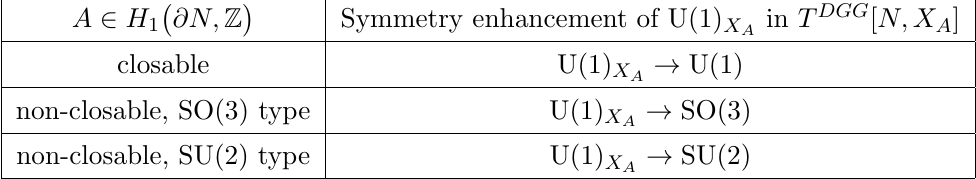
Table 1 . Symmetry enhancement in T DGG [ N; X A ]. The de(cid:12)nitions of \SU(2) = SO(3) types" are explained in section 2.2. The de(cid:12)nitions of \closable/non-closable" are explained in section